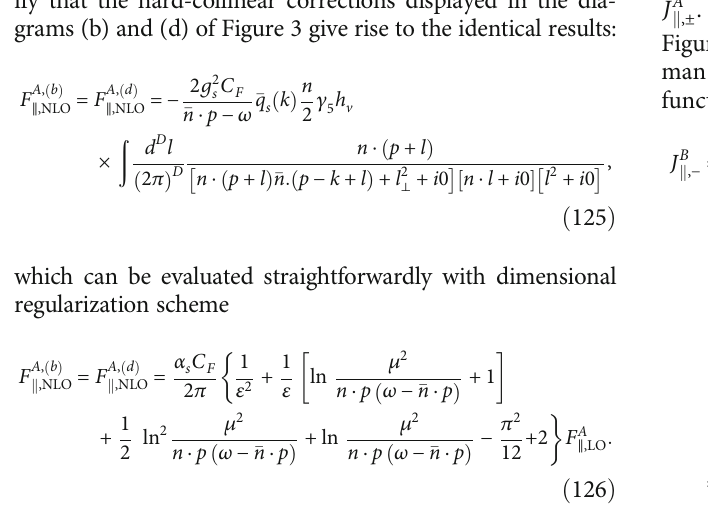
Figure 3: Diagrammatic representation of the vacuum-to- B -meson correlation function Π A (cid:1) ξ Þ γ = ð and the power suppressed interpolating current j ð 2 Þ ξ W h O ð A 0 Þ c v 5 k